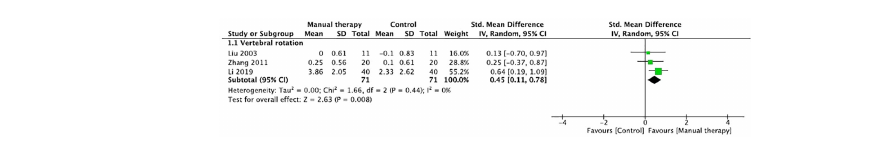
FIGURE 7 Forest plot of the effect of manual therapy for idiopathic scoliosis in vertebral